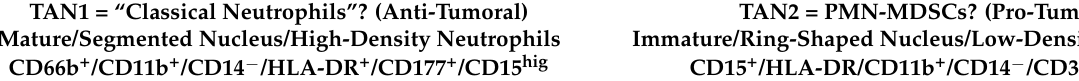
Table 1. Functional properties of TAN1 and